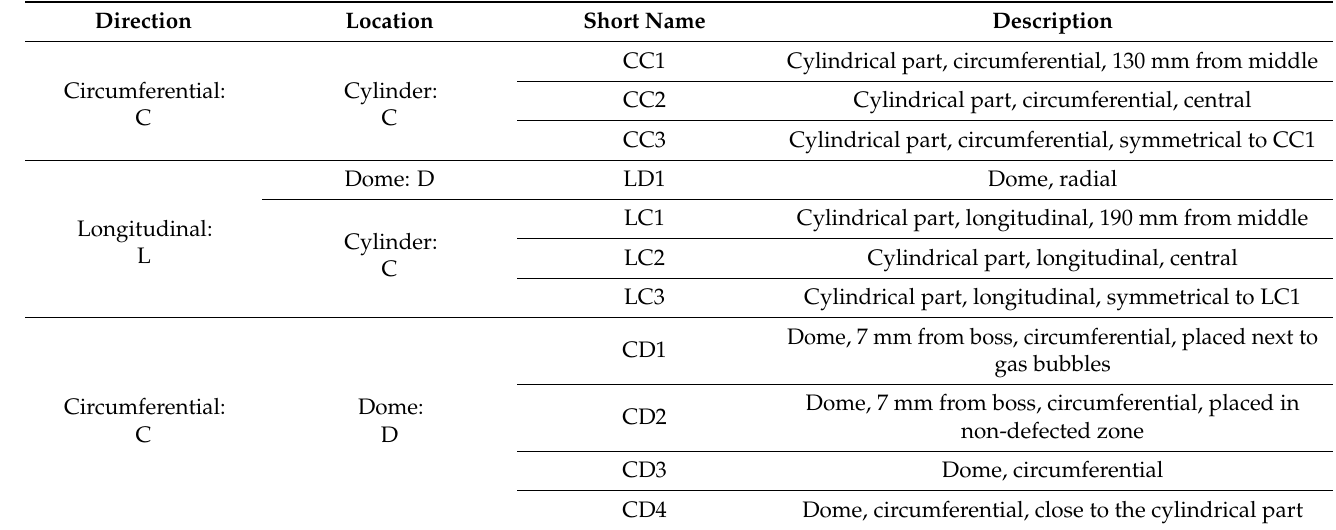
Table 1. Description of the placement of optical strain sensors.